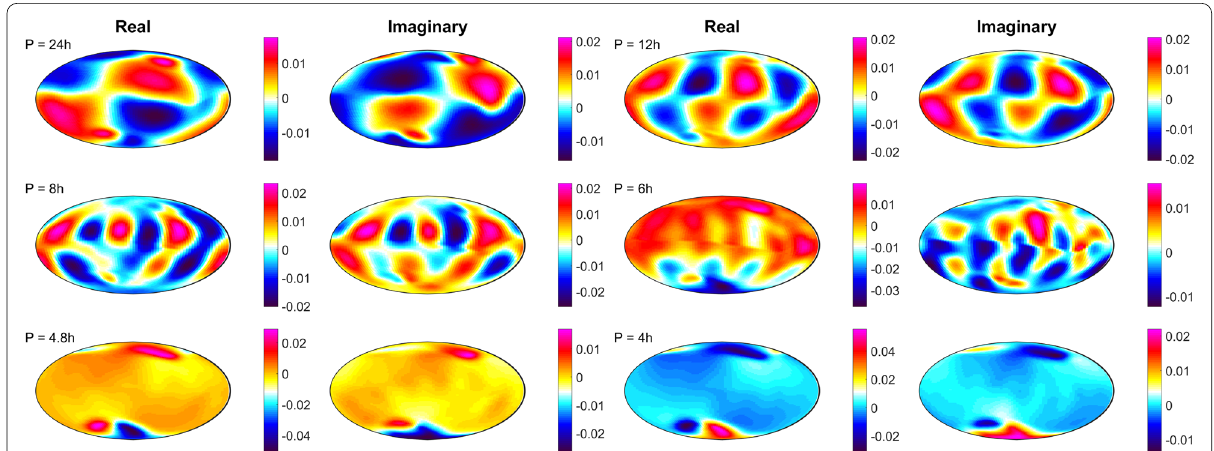
Fig. 7 Maps of the first, dominant mode for each period P 24 h. Both real and imaginary parts are displayed. Scaling is normalized and unit-less